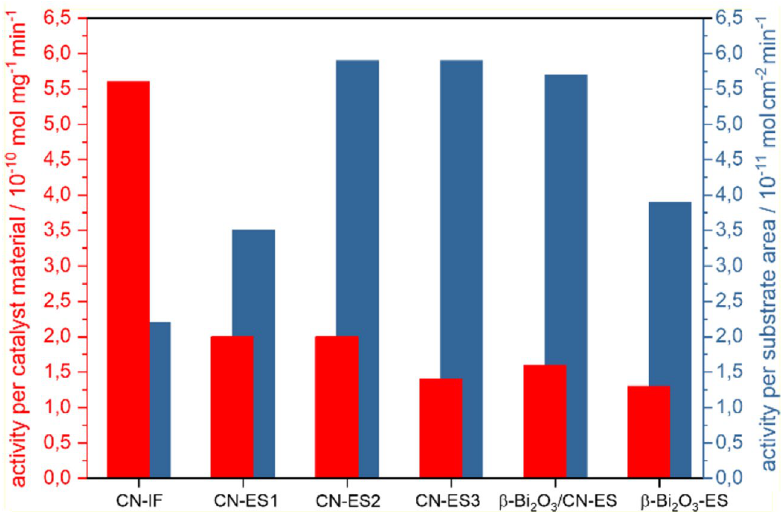
Fig. 6 Comparison of the pho- tocatalytic activity per applied catalyst mass (left) versus the activity per substrate area (right) for different